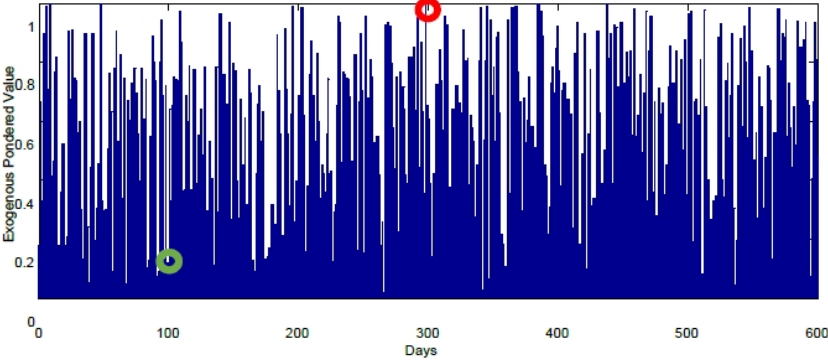
Figure 11. Representative exogenous pondered value forecasting per day.